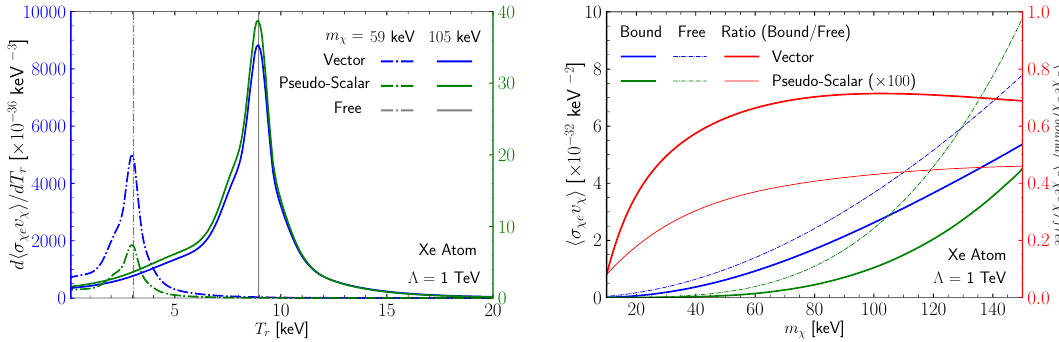
Figure 1 . ( Left ) The atomic effects of Xe on the electron recoil spectrum with two typical DM masses m = 59 keV (dot-dashed) and 105 keV (solid) for vector (blue) and pseudo-scalar (green) χ operators. Since the pseudo-scalar cross section is sensitive to the DM mass, the left axis adopts a scale of O (1000) in blue for the vector case while the right one of O (10) in green for the pseudo-scalar one. ( Right ) The atomic effects on the thermally averaged total cross section with velocity weight h σ χe v χ i for vector (blue) and pseudo-scalar (green) cases. Comparison has been made between the scattering cross section with a bound (thick) and free (thin) electron while the bound/free ratios are shown in red color according to the right axis